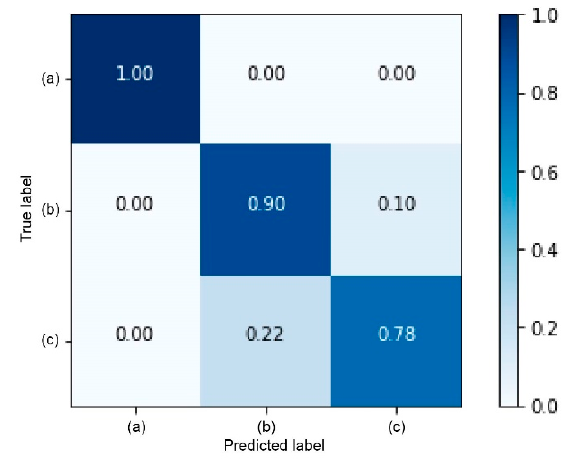
Figure 11. Normalized confusion matrix of test.